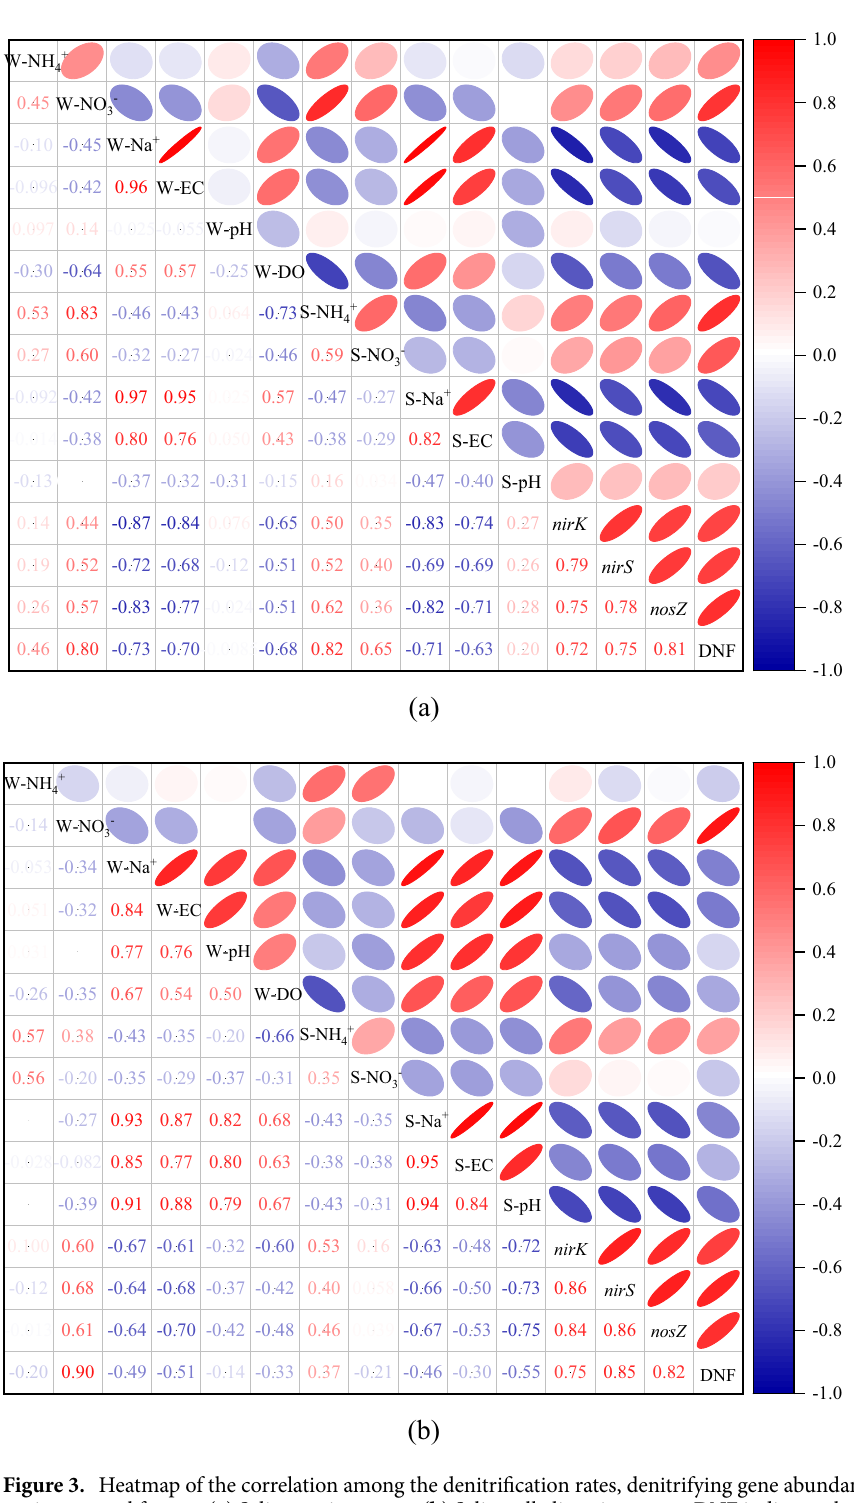
Figure 3. Heatmap of the correlation among the denitrification rates, denitrifying gene abundances and environmental factors. ( a ) Saline environment; ( b ) Saline-alkali environment. DNF indicates the denitrification rate. The numbers on the lower left indicate the correlation coefficients of the denitrification rates, denitrifying gene abundances and environmental factors; a coefficient value > 0.31 indicates that the correlation between the two variables is significant at a 95% confidence level. The shaded ellipses on the upper right indicate the direction and magnitude of the interactions between two variables. The darker the red/blue shades are, the greater the positive/negative correlations between two variables. “W-” and “S-” indicate the overlying water and sediment, respectively. The figures were created using Origin 9.0 (OriginLab Corporation,